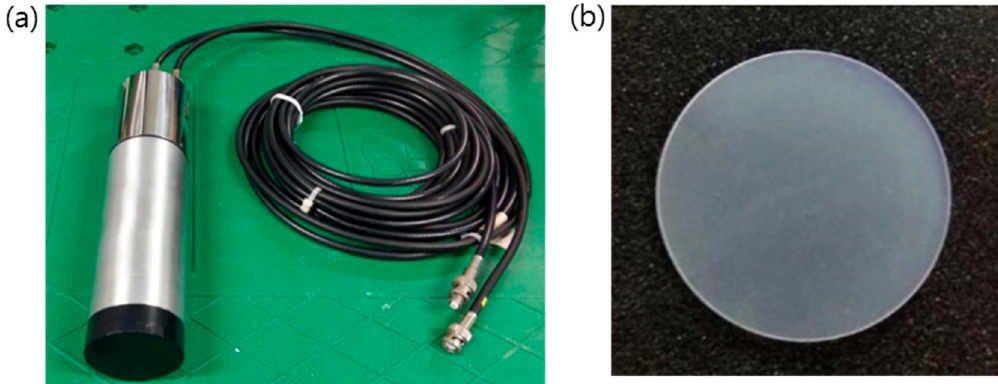
Figure 26. In-situ prototype detector [92].